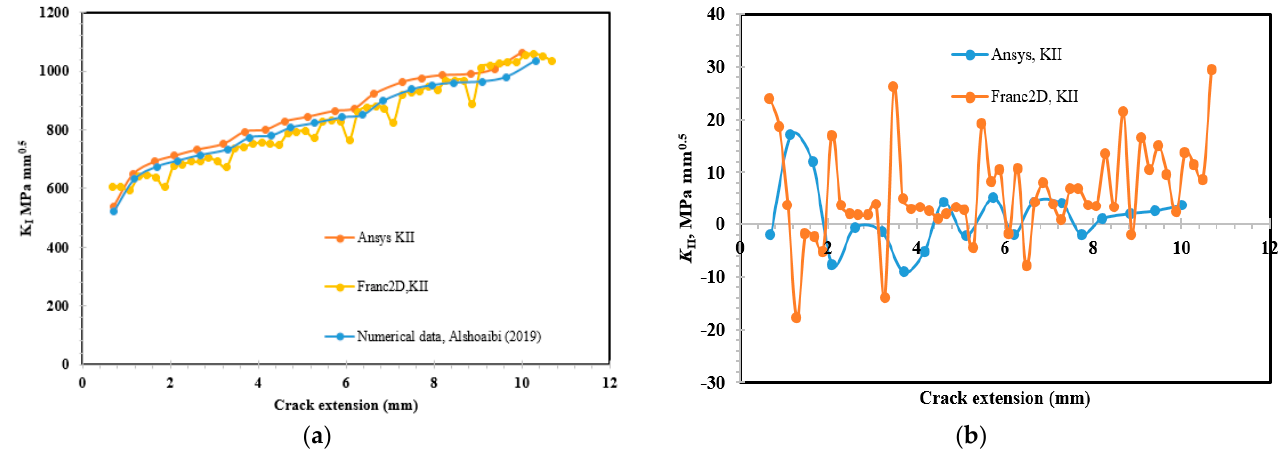
Figure 9. Stress intensity factors with corresponding crack length for specimen G3, ( a ) K I, and ( b ) K II .